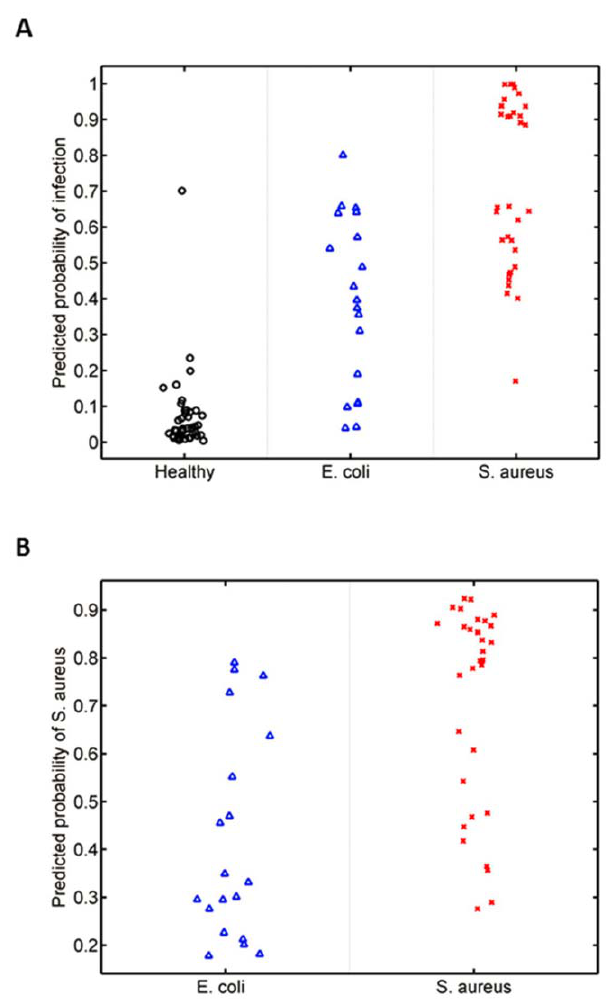
Figure 4. Performance of the human S.aureus classifier. (A) The human S. aureus classifier differentiates S. aureus BSI from both uninfected controls and E. coli BSI. (B) A separate classifier was generated using only S. aureus and E. coli -infected human subjects and tested using leave-one-out cross-validation.